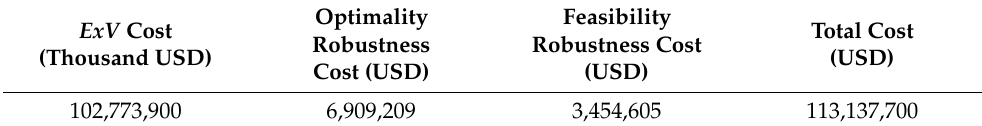
Table 2. Breakdown of the total cost of the wood pellet SC according to the fuzzy-FRPP approach. ExV Cost (Thousand USD)